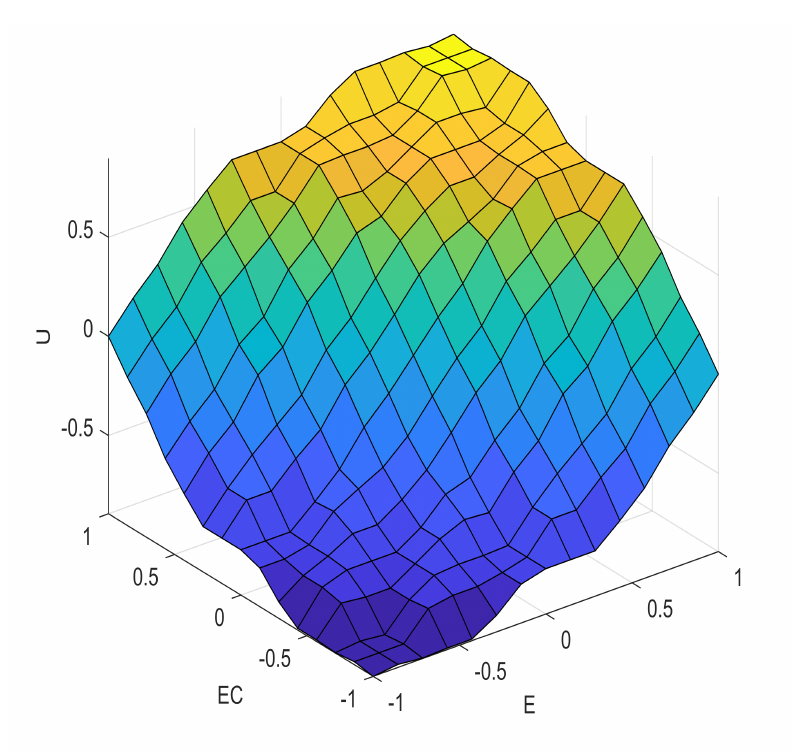
Figure 12. Rule Viewer.